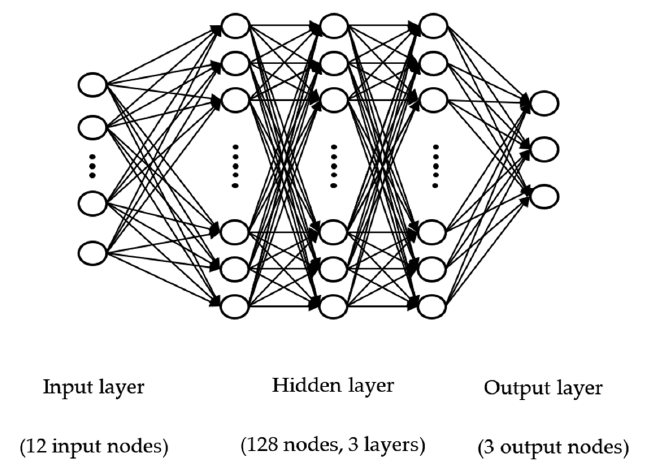
Figure 13. Action decision deep neural network.